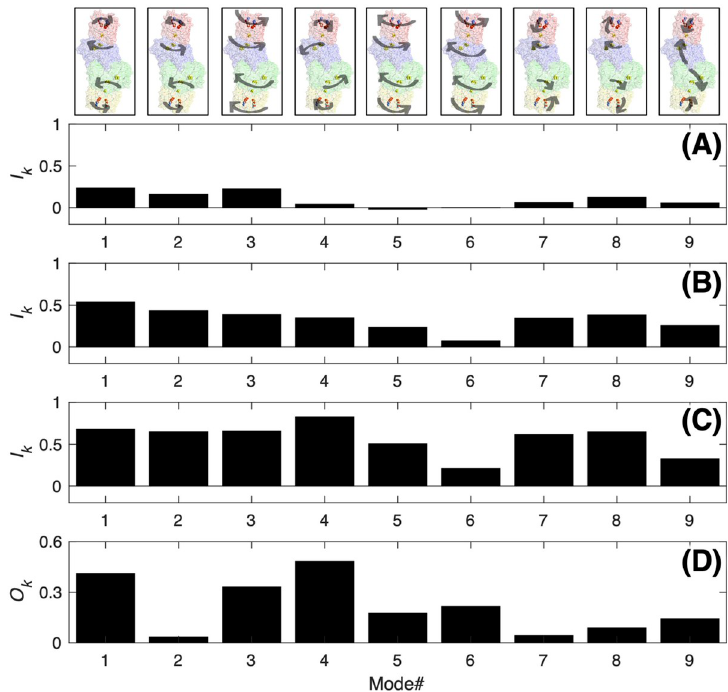
Fig 7. Normal mode decomposition. Top 9 normal modes of the ATP-bound nitrogenase complex (top panels) and their influences on the mechanical coupling between (A) Fe 1 and α 1 β 1 , (B) Fe 1 and Fe 2 , (C) P-loops in Fe 1 and P-loops in Fe 2 ; (D) overlap between the normal modes of the ATP-bound nitrogenase and the vector describing the displacement of the Fe protein that takes place upon ATP hydrolysis as inferred from the ATP- and ADP-bound crystal